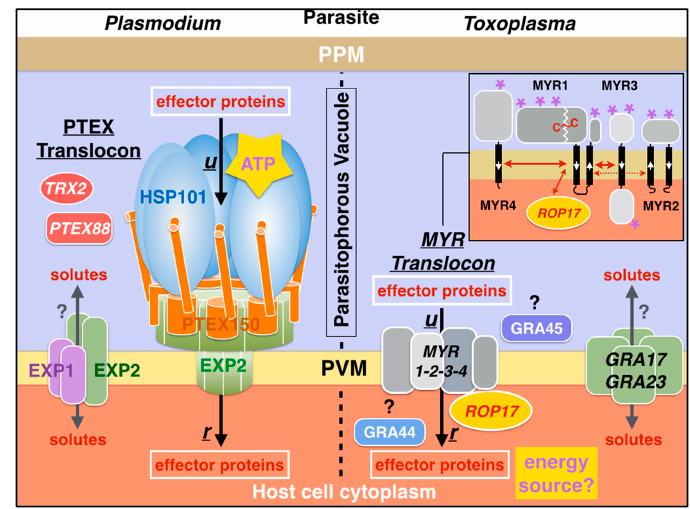
Figure 10. Comparison of the vacuolar translocation and transport pathways in the apicomplexans Plasmodium and Toxoplasma . Effector protein translocation is mediated by the PTEX in Plasmodium and the MYR complex in Toxoplasma . u and r indicate unfolding and refolding steps prior to and after translocation. PTEX subunit EXP2, in association with another vacuolar membrane protein EXP1, is involved in the transport of small molecules across the membrane; this activity seems independent from the protein secretion activity [36] . The rhoptry kinase ROP17 phosphorylates one or several MYR proteins and is required for effector translocation. Contrary to PTEX, MYR does not seem to use an AAA+ unfoldase. The inset describes the possible topologies of insertion of the four MYR proteins in the vacuolar membrane based on biochemical data and structural predictions of transmembrane domains (black thick lines with white arrows pointing towards the C -termini). MYR1 and MYR3 form a stable interaction. Red double-headed red arrows highlight strong interactions between MYR1 and proteins MYR3 and MYR4 while interaction with MYR2 is transient. The two fragments generated upon proteolytic cleavage of the TEXEL in MYR1 are disulfide linked. Purple asterisks indicate putative serine phosphorylation sites [106,108] . Three additional proteins MYR4, GRA44, and GRA45 complete the MYR translocon [109] . The insertion topology of MYR proteins and cellular localization of GRA44 (vacuolar lumen vs. host cytoplasm) are not yet elucidated. GRA45 has been localized to the vacuole lumen [110] . All these proteins are necessary for effector export in Toxoplasma , yet very little is known about their structure and organization into a functional vacuolar translocation complex. As in the case of Plasmodium EXP2, PTEX150, and PTEX88, surveys of protein sequence and protein structure databases combined with secondary structure predictions fail to reliably identify any known functional or structural homologues. For example, the C -terminus part of MYR1, where two TMH are predicted, is hypothesized to bear some resemblance with protein TatC, one of the three components of the twin-arginine translocon system (Tat), an Sec-independent periplasmic translocase capable of translocating folded proteins, present in Bacteria, Archea but also plastids and mitochondria [106]. The sequence homology is, however, weak and such predictions should be taken with caution, as they can be misleading as exemplified by the case of Pf -EXP2, erroneously predicted to resemble a hemolysin E bacterial toxin. Overall, the structural basis and energetics of vacuolar secretion in Toxoplasma remain largely unknown.